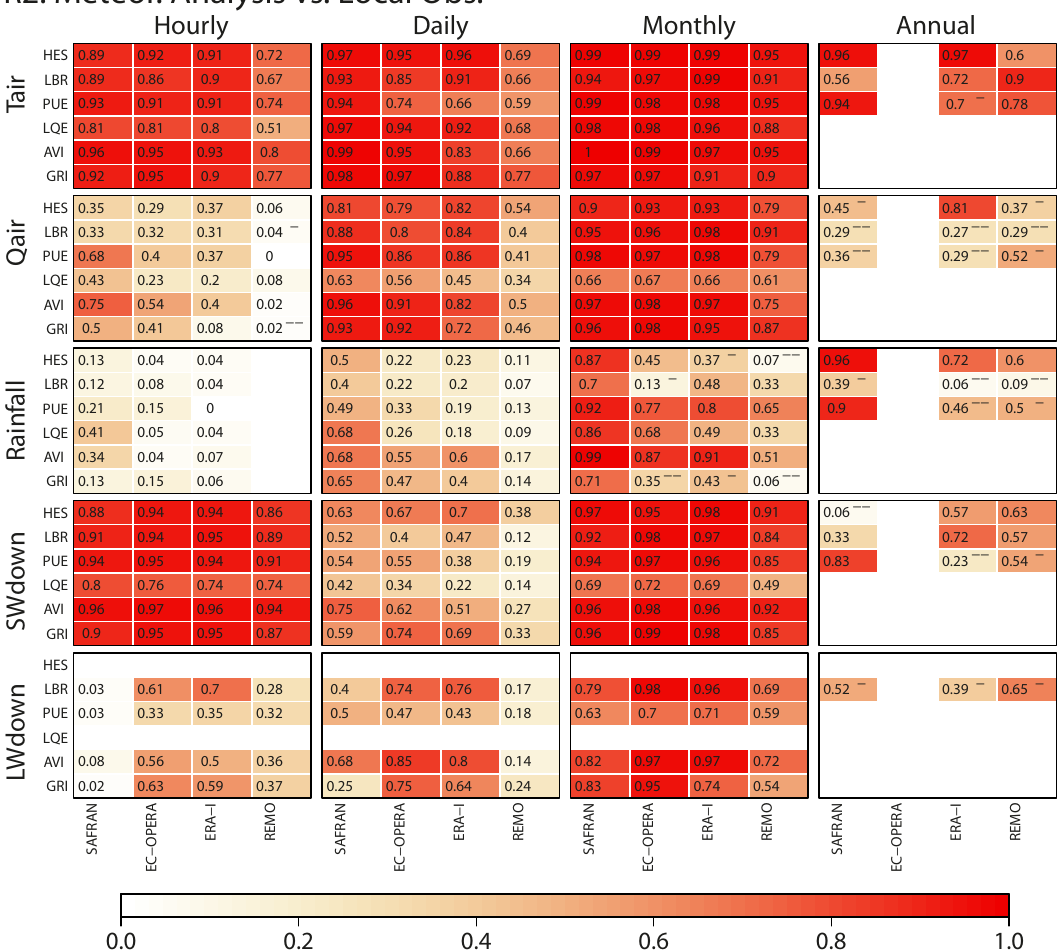
site has the smallest R 2 (0.20, p < 0 . 01), with low Q air